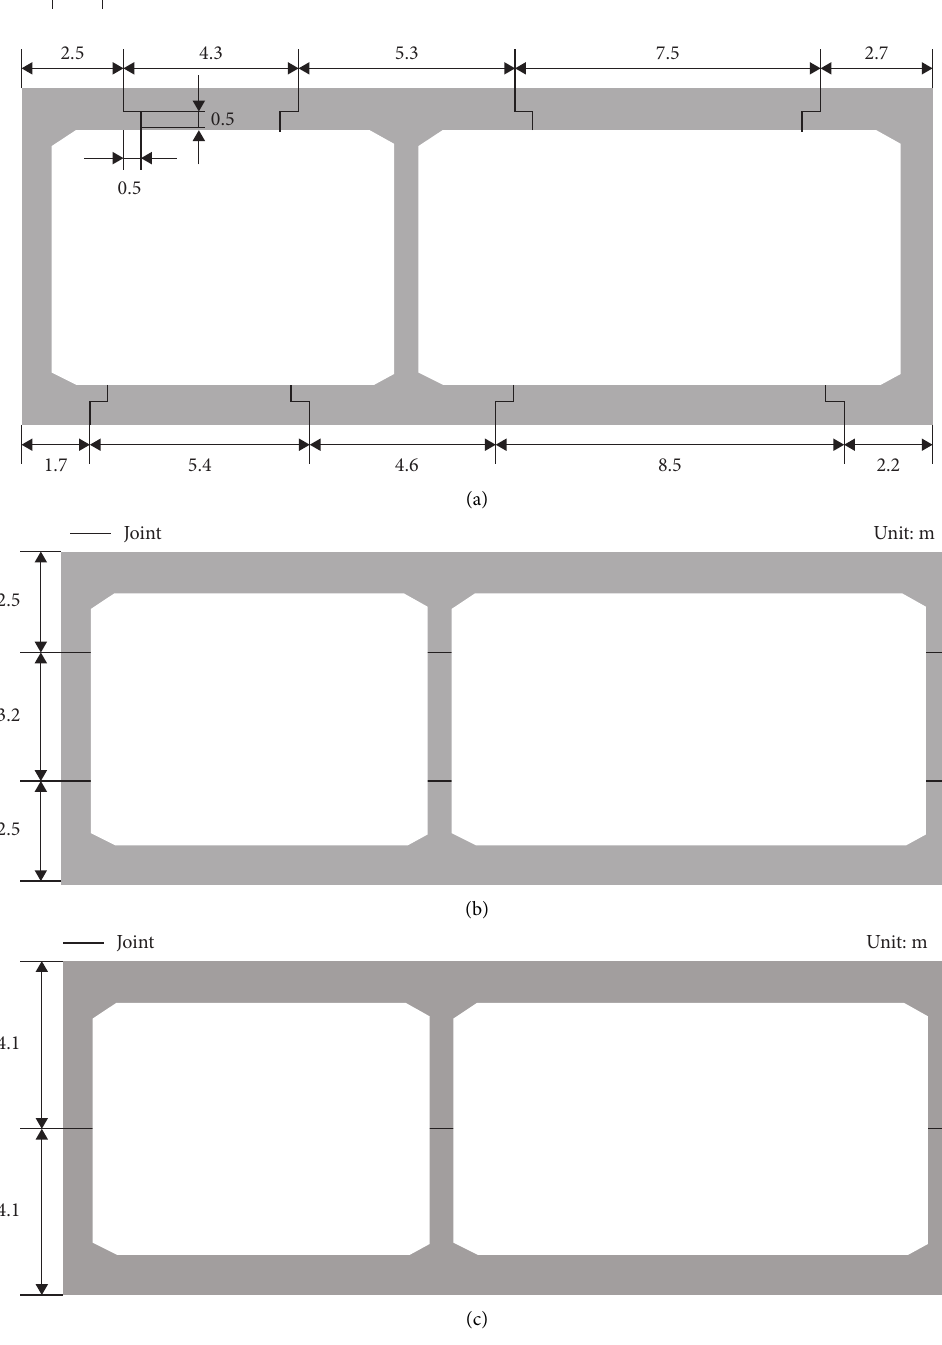
Figure 4: Preliminary division schemes: (a) scheme 1, (b) scheme 2, and (c) scheme